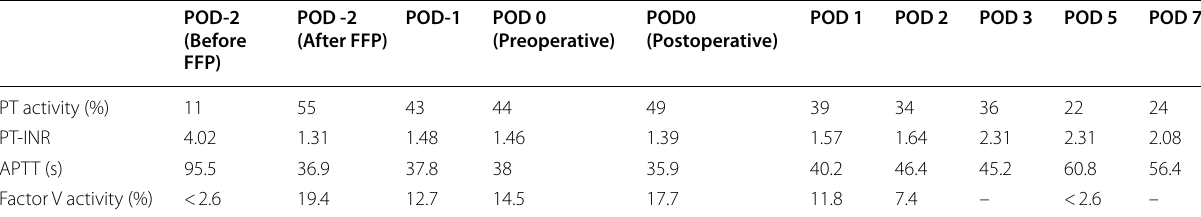
Table 2 Perioperative blood coagulation data